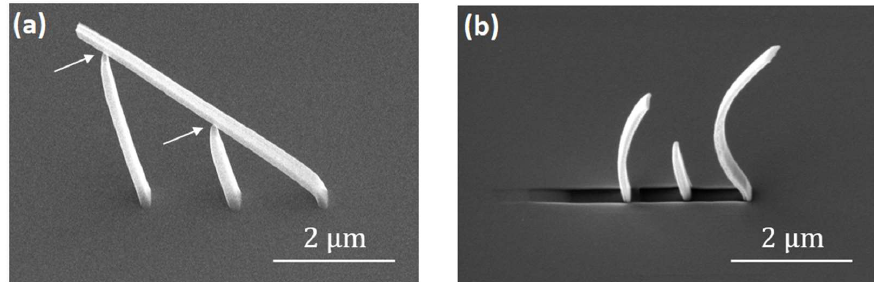
Figure 10. Nanostructure deformation upon thermal evaporation. ( a ) Example structure in which support legs do not fully contact the 3D nanowire, as highlighted by the arrows; ( b ) The same structure after thermal evaporation of a 50 nm Permalloy